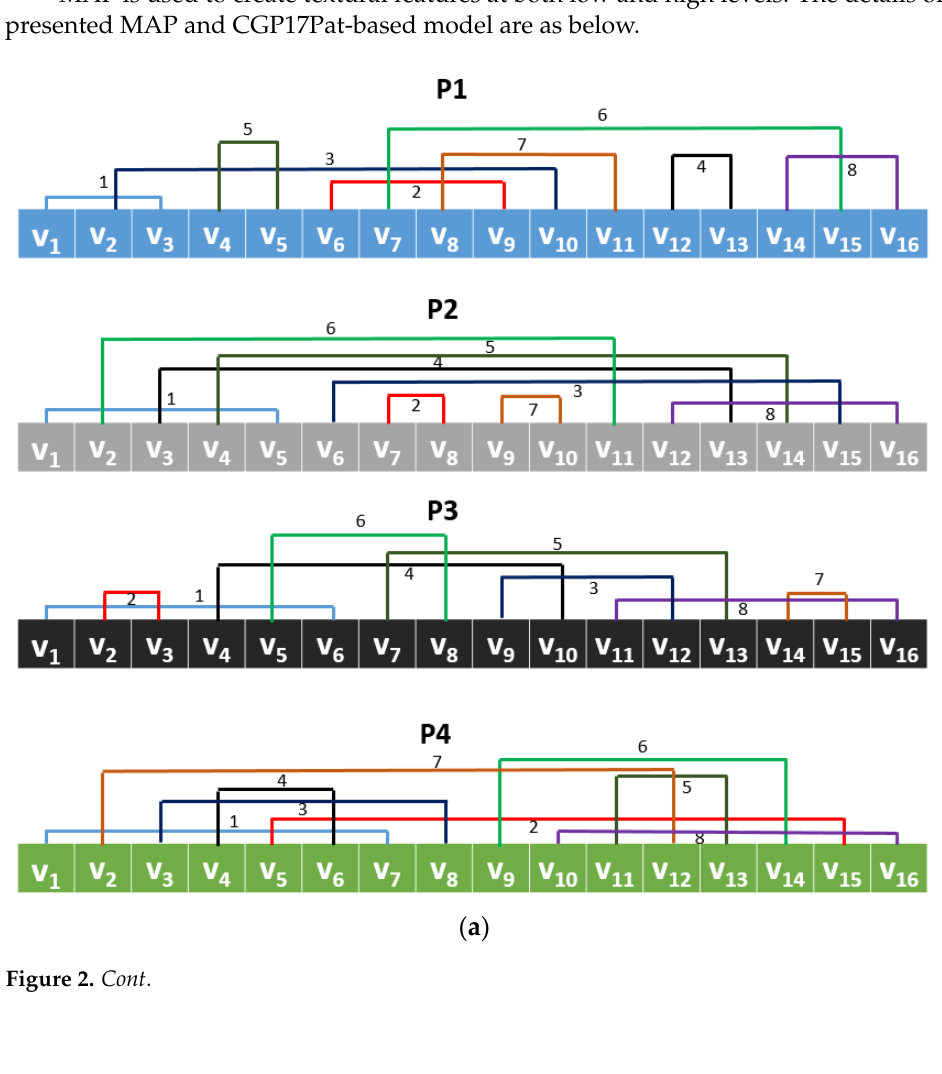
Table 3. Generated cyclic group of 17